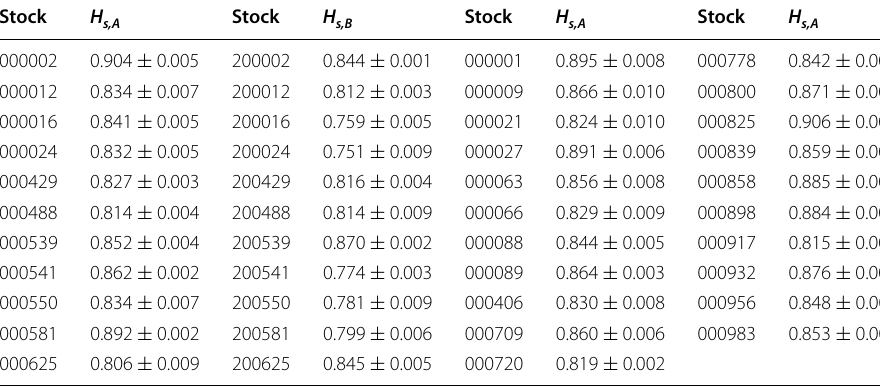
H s 0.841 0.036 for all stocks, � � = ±